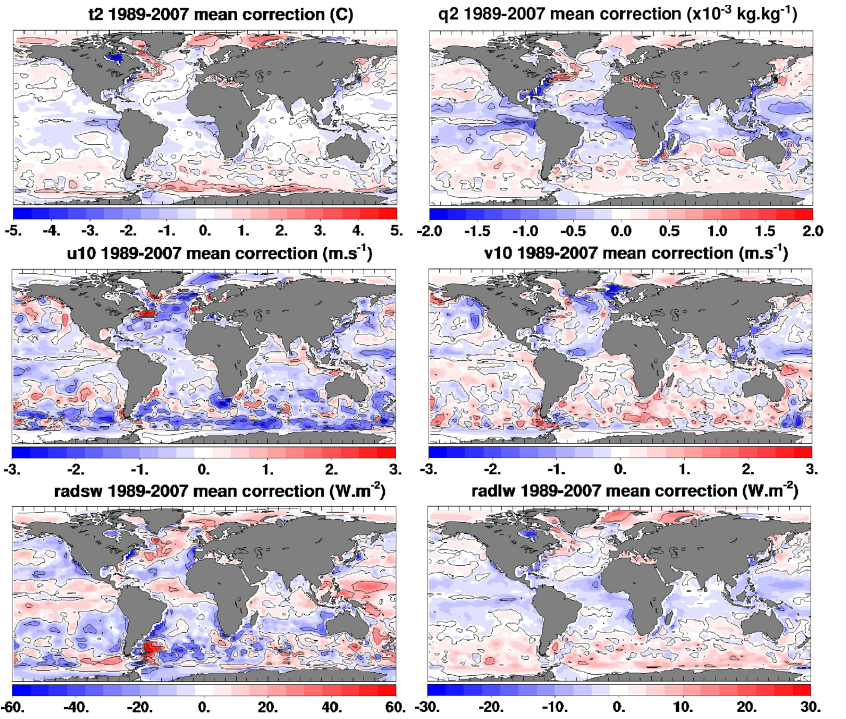
Fig. 4. 1989–2007 mean computed corrections of temperature ( t 2 ), humidity ( q 2 ), zonal wind speed ( u 10 ), meridional wind speed ( v 10 ), downward shortwave radiation (rad sw ), and downward long-wave radiation (rad lw ).